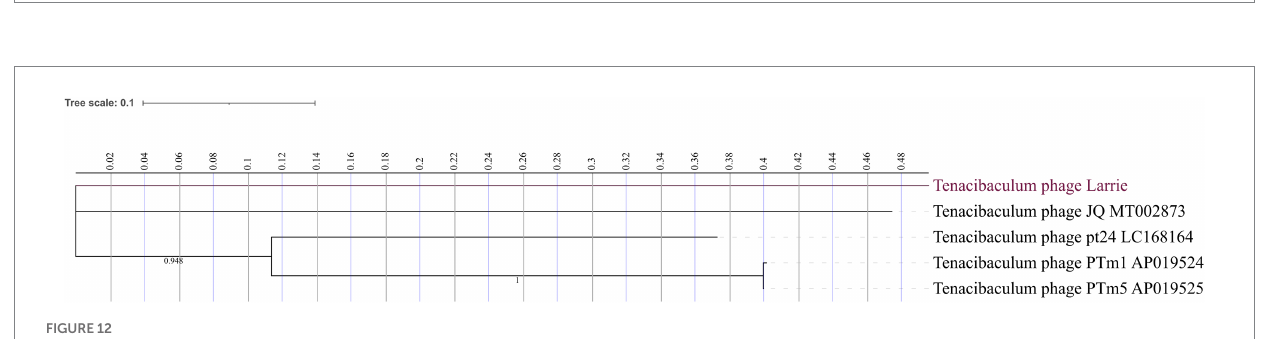
FIGURE 12 Phylogenetic tree of Tenacibaculum phage Larrie. The large terminase subunits aa sequences of Tenacibaculum phages were downloaded from NCBI VIRUS database and aligned using MUSCLE algorithm. A maximum likelihood phylogenetic tree was constructed using MEGA X. The tree was visualized using Interactive Tree of Life (ITOL). The bootstrap value was denoted in each